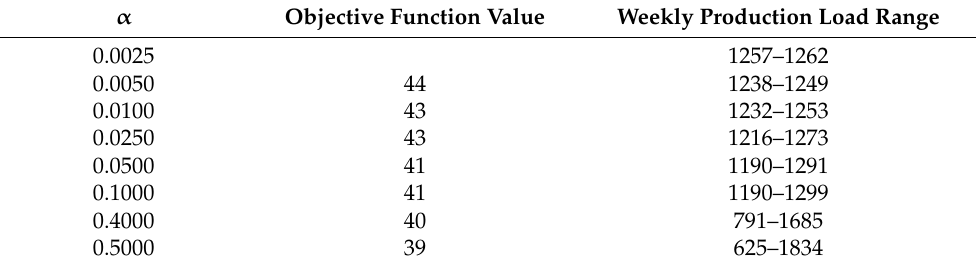
Table 7. Results of Case 2 at various values of α .